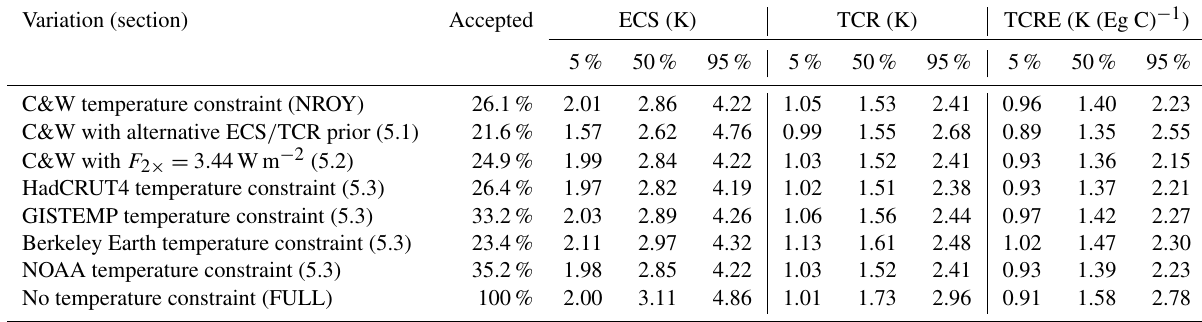
Table 7. Sensitivity in the ECS, TCR and TCRE to variations in the underlying assumptions in the FAIR large ensemble. For the sensitivity experiments the section number in the paper describing the change is given. The “accepted” column details the proportion of the 100000- member FULL ensemble that satisfied the specified temperature constraint.